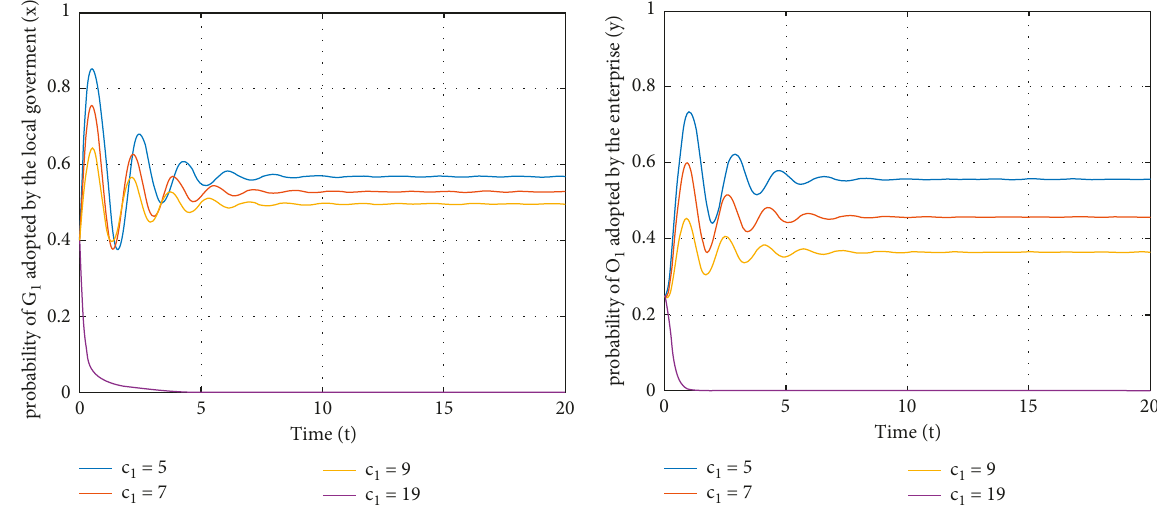
Figure 8: The impact of raising the upper limit of c